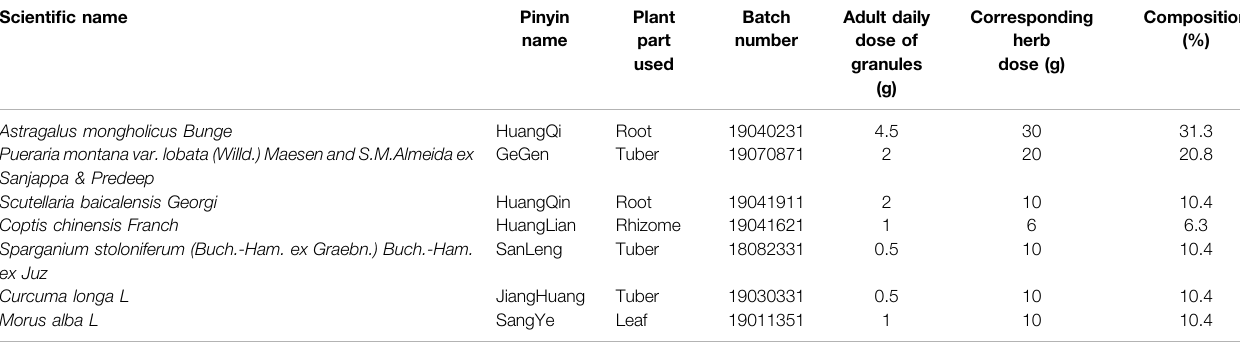
TABLE 1 | Composition of Yiqi Jiedu Huayu